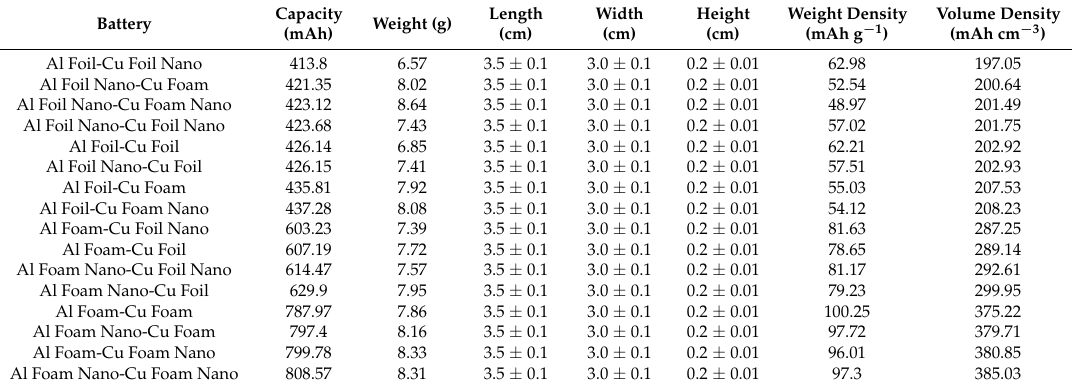
Table 2. Capacity densities of lithium ion batteries with various current